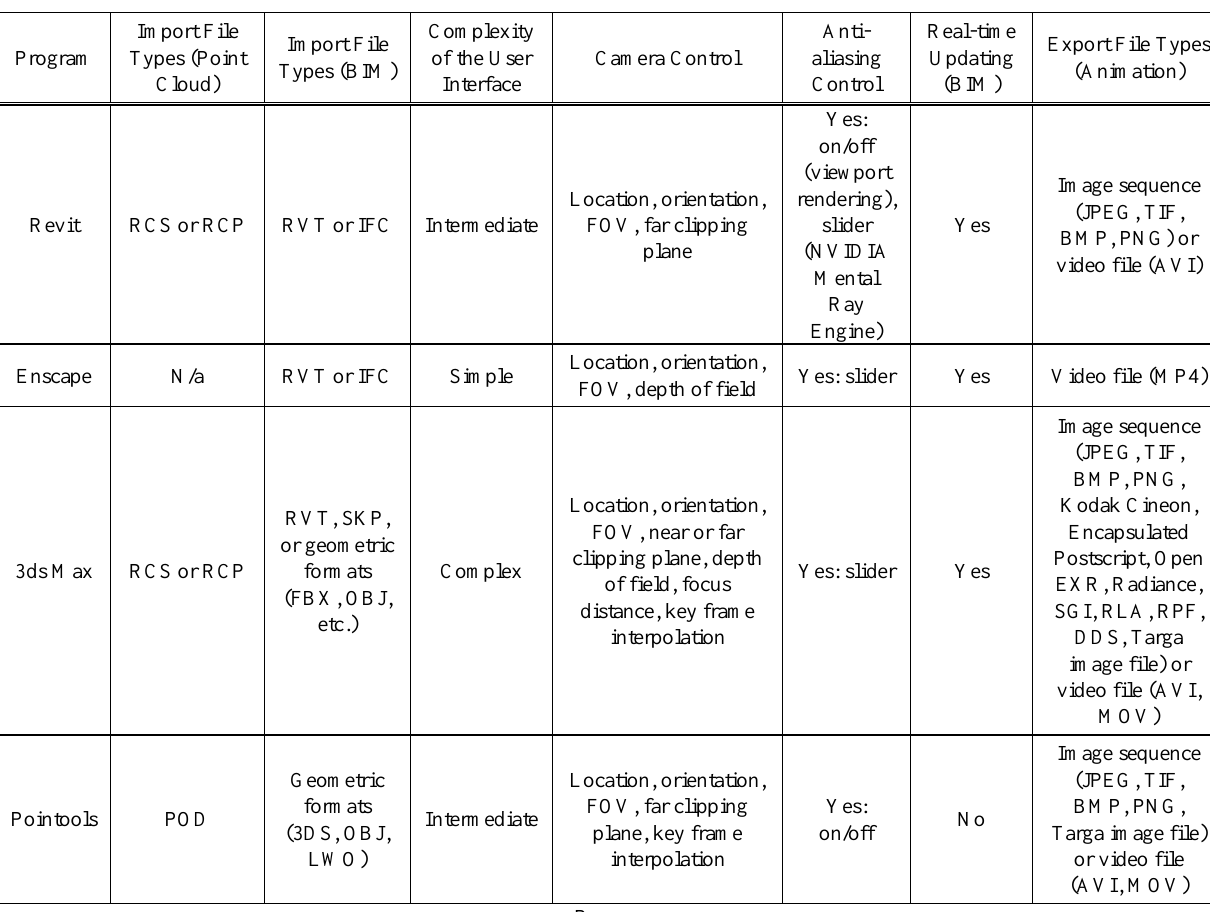
Table 1. Summary of the evaluation of the programs for leveraging BIMs and point clouds for